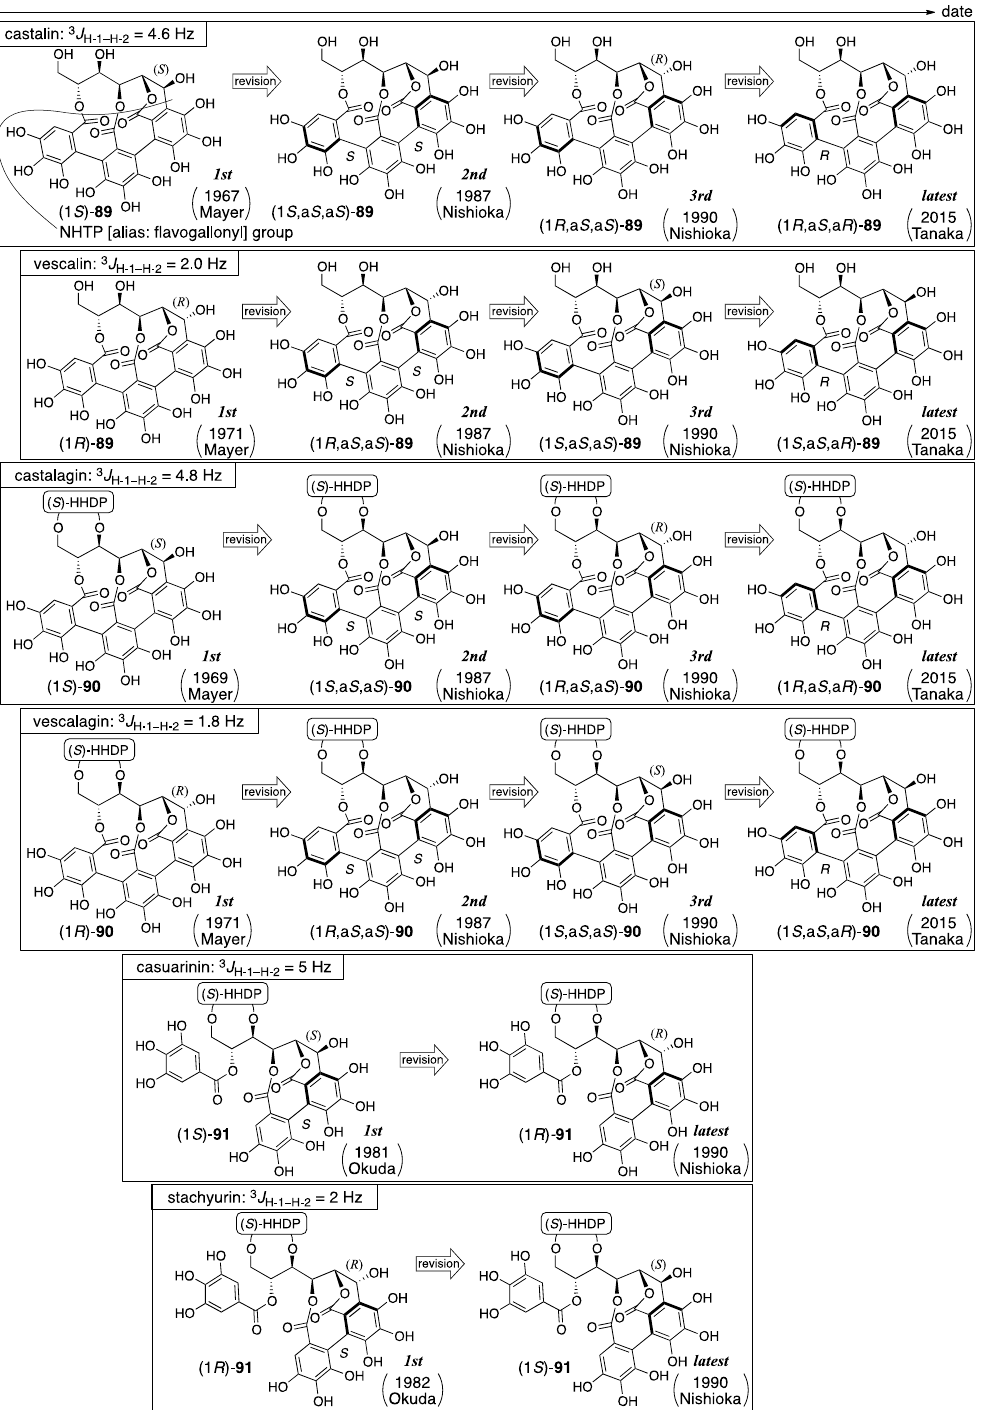
Figure 34. The transition of the structure of castalin, vescalin, castalagin, vescalagin, casuarinin, and